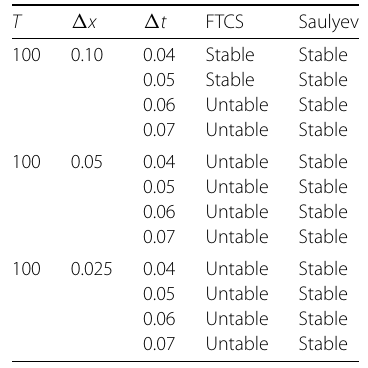
Table 4 Physical parameters of simulation 2 D s (m 2 /s) u s (m/s) u w (m/s) K L (km) T (s) 0.1 0.065 0.3 0.3 108 100 0.1 0.065 0.25 0.3 108 100 0.1 0.065 0.2 0.3 108 100